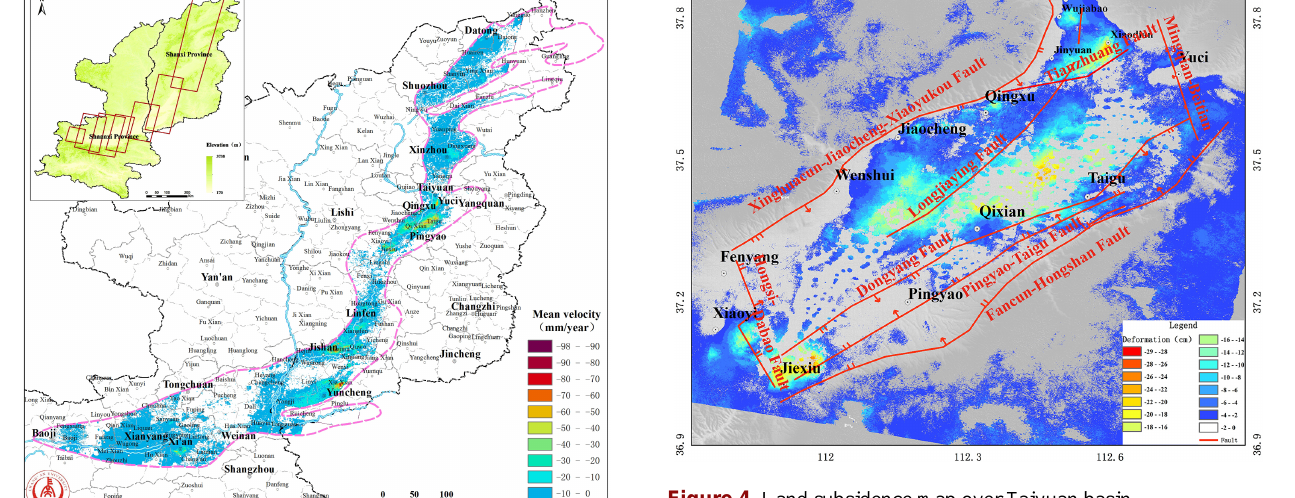
Figure 4. Land subsidence map over Taiyuan